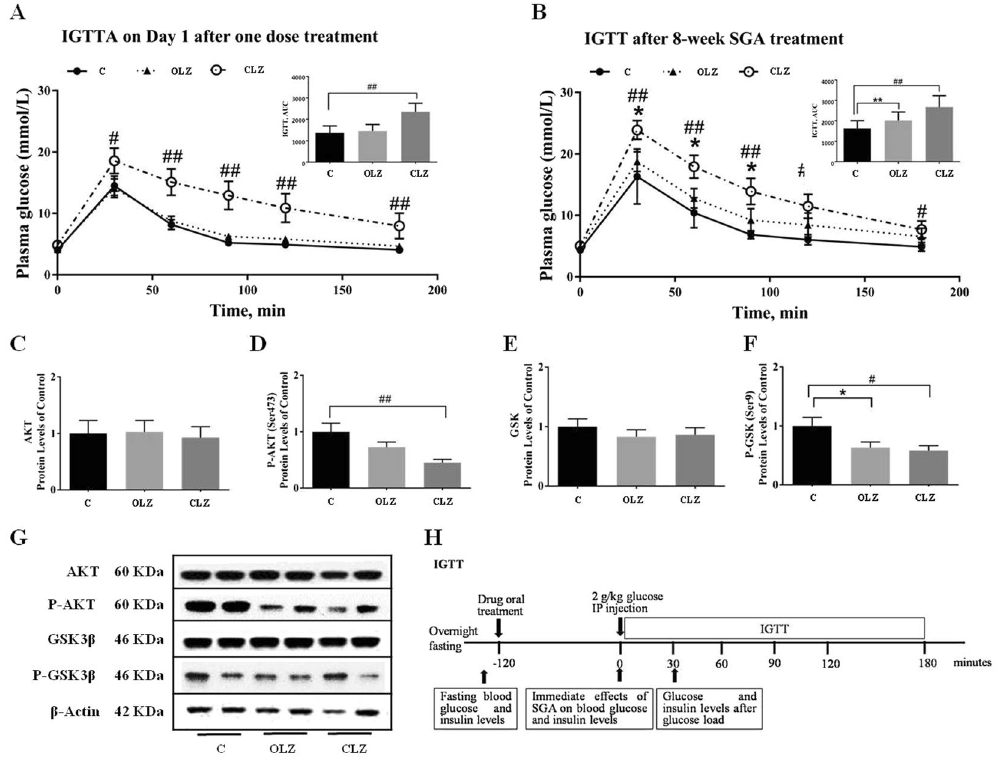
Figure 5. Effects of OLZ or CLZ on glucose metabolism. ( A and B ) IGTTs were conducted in rats after one dose treatment at Day 1 and after 8-week chronic OLZ or CLZ treatment. Data represent mean ± SEM (n = 12 per group). ( C–F ) Presents the levels of AKT, phosphor-AKT (Ser473), GSK, and phosphor-GSK (Ser9) in the liver. ( G ) Shows the representative western-blotting images. ( H ) Experimental protocol describing IGTT on Week 0 and 8. Data were normalised by taking the average value of the control group as 100% and expressed mean ± SEM of 2 independent experiments done in duplicate (n = 6 per group). * p < 0.05, ** p < 0.01 and *** p < 0.001: OLZ treatment vs. control, # p < 0.05, ## p < 0.01 and ### p < 0.001: CLZ treatment vs. control. C: control; OLZ: olanzapine; CLZ: